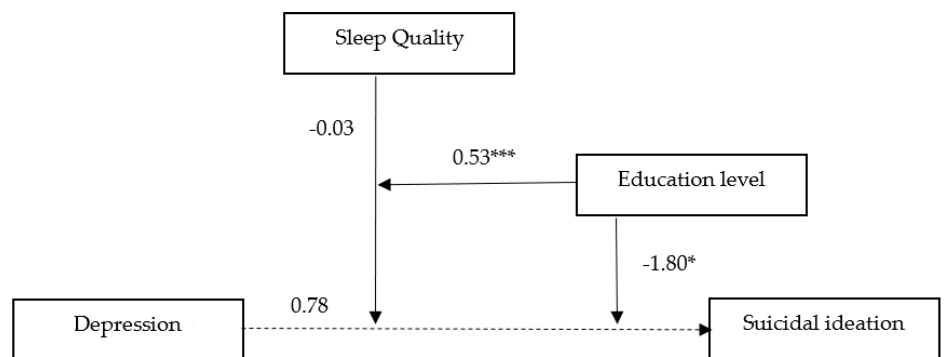
Figure 4. Moderated moderation effect of the sleep quality and education level between depression and suicidal ideations. An unstandardized regression coefficient (B) was reported as the moderation effect. * p < 0.05 and *** p <